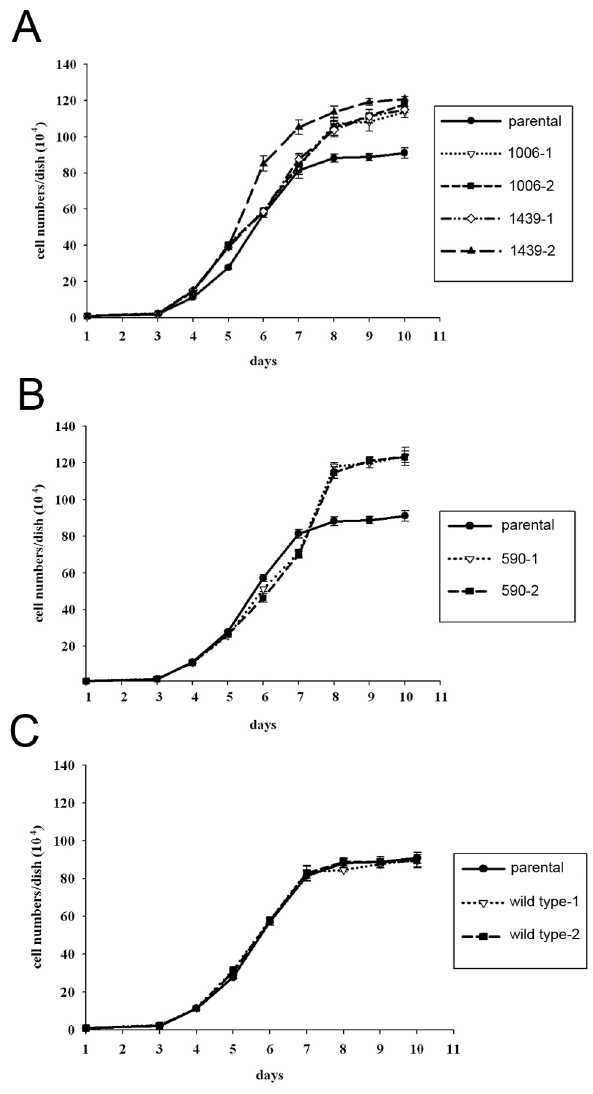
Figure 3. Growth curve of the cells expressing mutant SWAP- 70 s. 1 6 10 5 cells were plated onto 6-cm dishes, and cell numbers were counted every day. The medium was changed every other day. For reference, the growth curves of the parental cells are shown in every graph. The symbols for the cell lines are shown in the right-hand boxes.